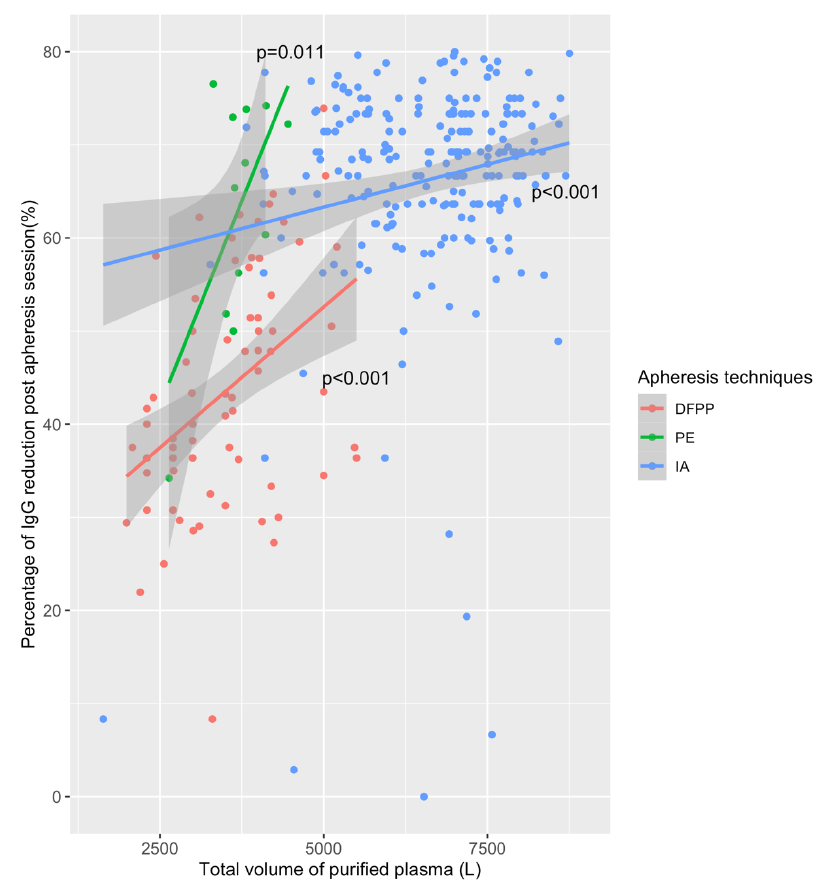
Figure 2. Post session reduction of immunoglobulin-G according to the apheresis technique. DFPP: double-filtration plasmapheresis; PE: plasma exchange; IA: immunoadsorption; IgG: immunoglobu- lin subtype G. IgG reduction was assessed in all sessions that did not received IV immunoglobulins. The volume of purified plasma is significantly associated with IgG